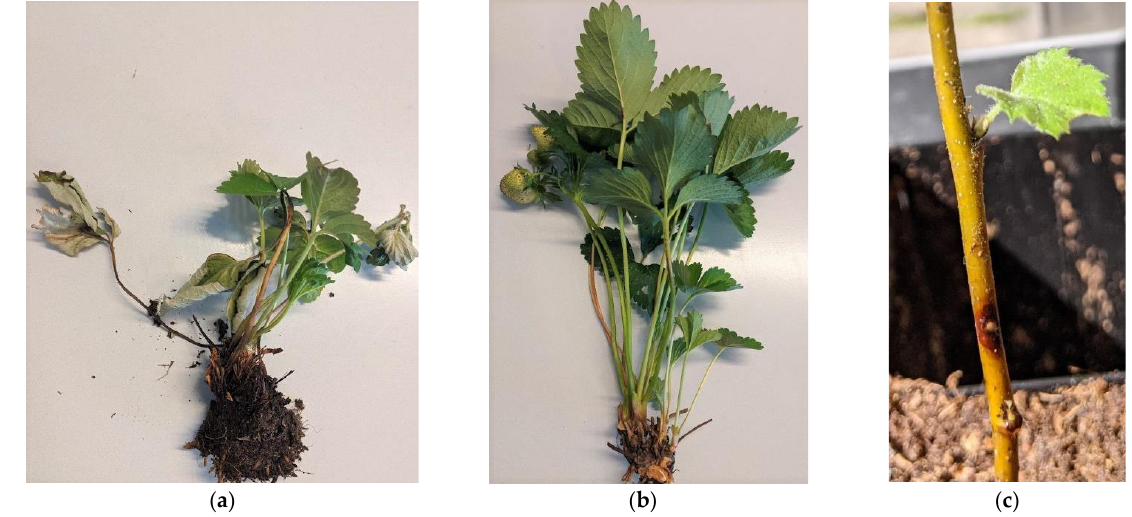
Figure 2. Fragaria × ananassa (Malling Centenary) 20 days post inoculation with Phytophthora cactorum isolates PhF17/19 ( a ) and PhF66 ( b ). ( c ) Betula pendula seedling six days post inoculation with P. cactorum isolate PhF66. Table 5. Increments of healthy leaves in garden strawberry plants after inoculation with Phytophthora cactorum strains in the pathogenicity test II. dpi = days post